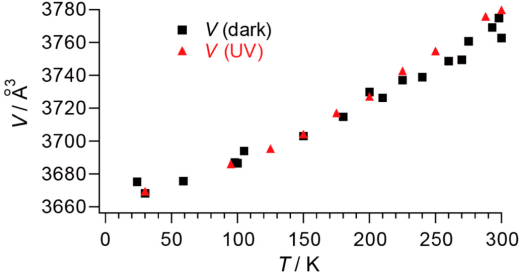
Figure 15. Temperature-dependence of cell volume of BPY[Au(dmit) 2 ] 2 . Squares (black) and triangles (red) are data obtained in the dark and under UV irradiation, respectively.